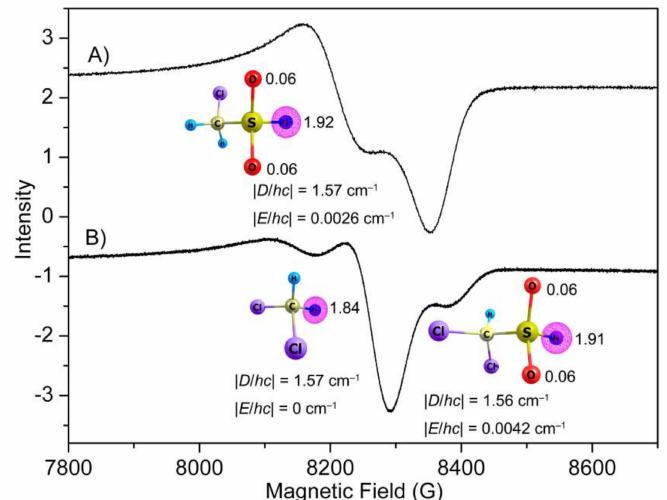
Figure 5. EPR spectra of the 266 nm laser photolysis products of CH 2 ClS(O) 2 N 3 ( A ) and CHCl 2 S(O) 2 N 3 ( B ) in glassy toluene matrices (0.4 mmol mL − 1 ) at 5 K. Natural spin densities of the nitrenes computed at the M06-2X/6-311++G(3df,3pd) level are